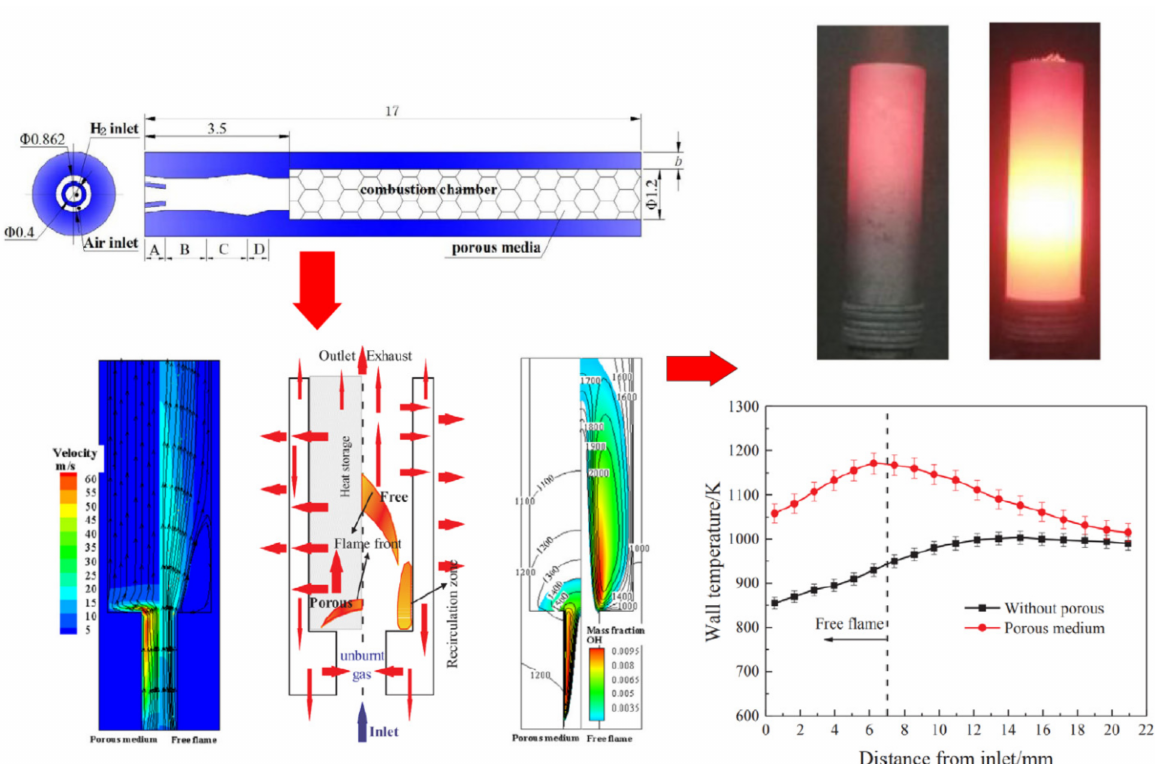
Figure 28. Distribution of exterior wall temperature in premixed H 2 /air combustion